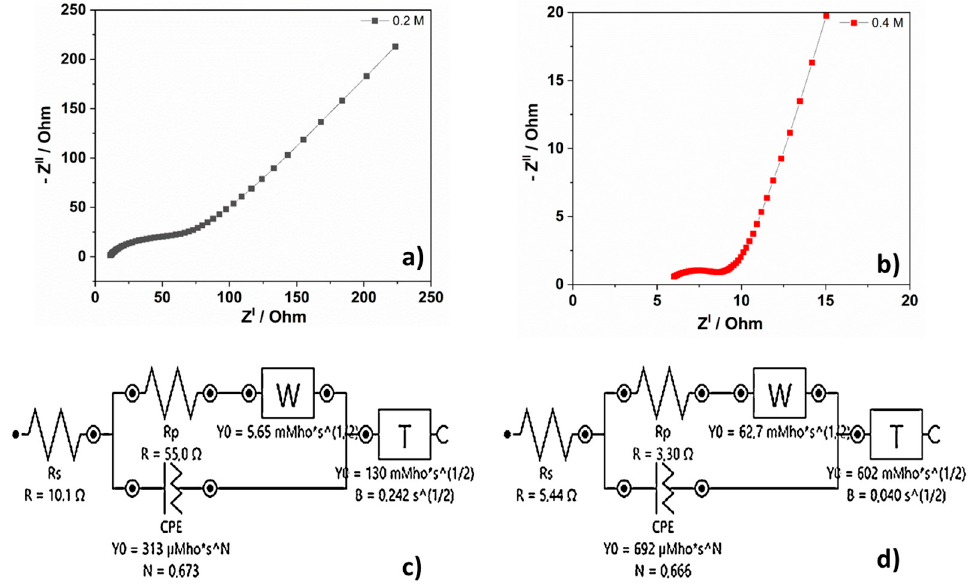
Figure 6. Nyquist plots of ( a ) 0.2 M sample and ( b ) 0.4 M sample. Equivalent circuit fi tt ing of the samples: ( c ) 0.2 M and ( d ) 0.4 M . samples: ( c ) 0.2 M and ( d ) 0.4